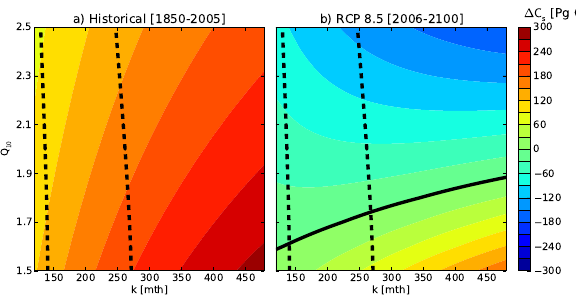
Figure 2. Change in total soil carbon in the reduced complexity model as a function of parameter values for each period as indicated. Dashed contours in panel (b) indicate model versions that produced soil stocks within the CI 95 of the Harmonized World Soil Database in 2005 (830–1550PgC). The thick black line represents no